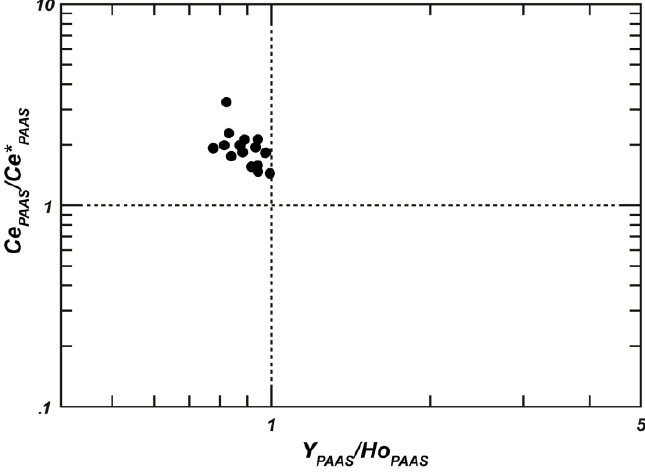
Figure 6. Genetic discrimination plot of the selected hydrogenetic crusts after [73].